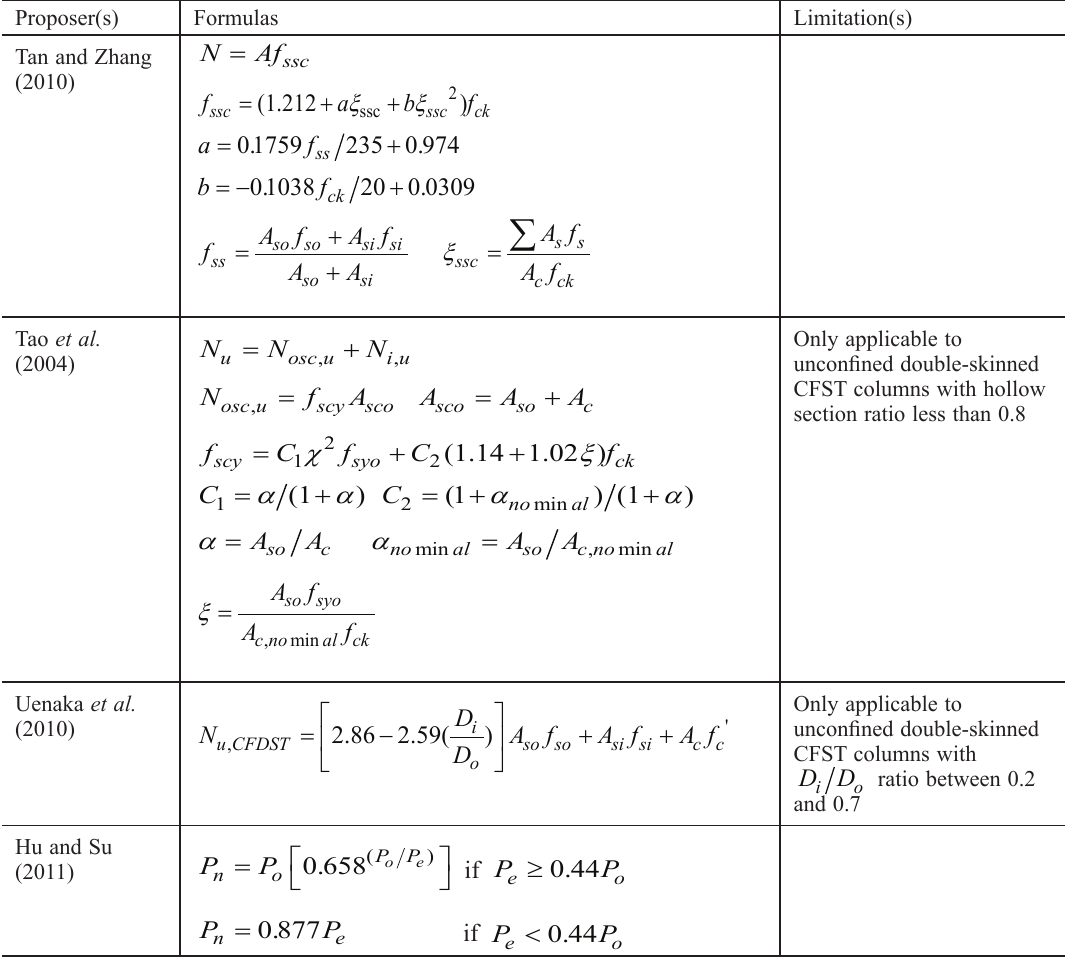
Table 3. Existing models for unconfined double-skinned CFST columns Proposer(s) Formulas Limitation(s)